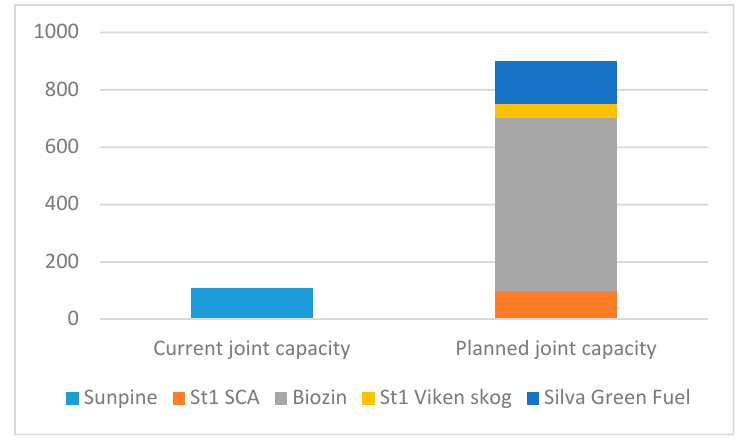
Figure 9. Collaborative projects. Source: [51–55].